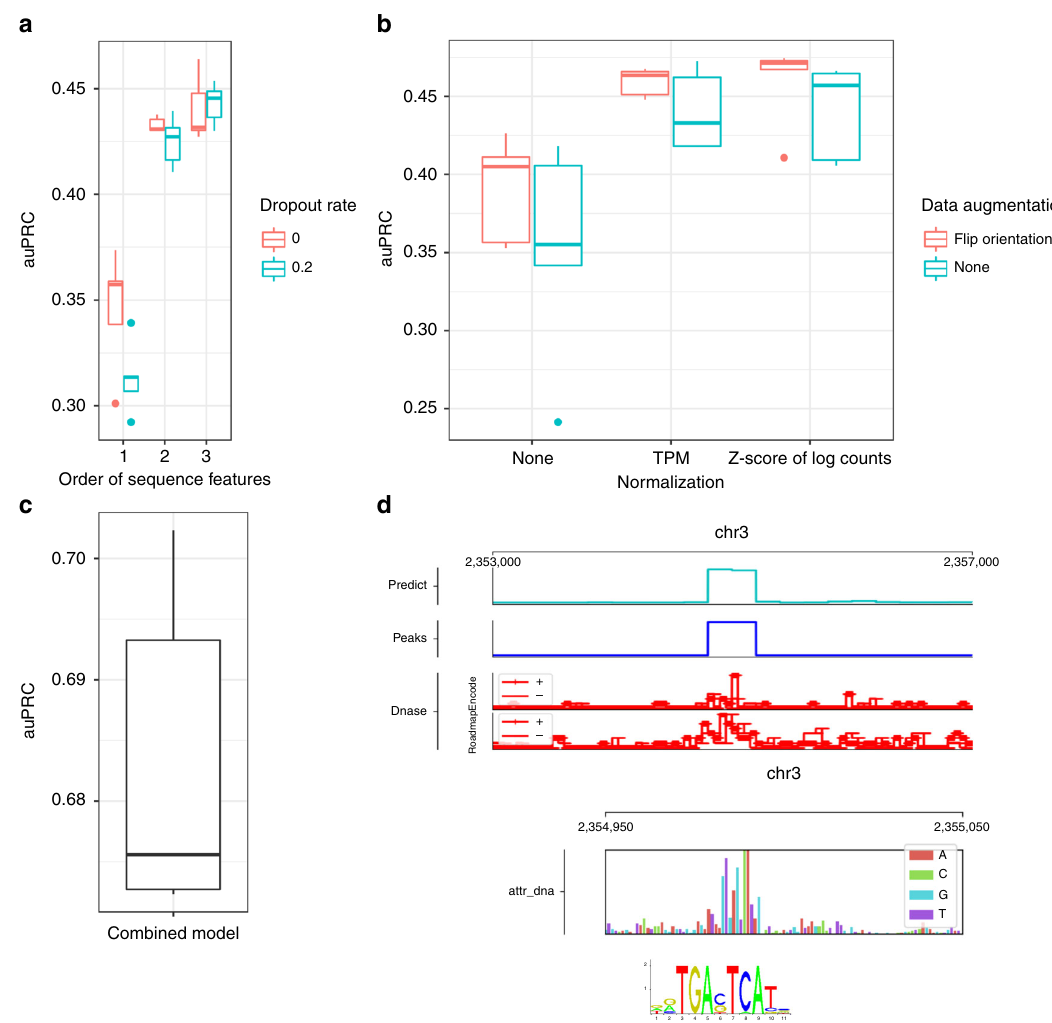
Fig. 2 Performance evaluation of JunD prediction. a Performance comparison of different one-hot encoding orders enabled by Janggu's Bioseq object. Order 1, 2, and 3 correspond to mono-, di- and tri-nucleotide based one-hot encoding, respectively. Each model was trained from scratch for fi ve times using random initial weights. Boxes represent quartiles Q1 (25% quantile), Q2 (median) and Q3 (75% quantile); whiskers comprise data points that are within 1.5 x IQR (inter-quartile region) of the boxes. b Performance comparison of different normalization and data augmentation strategies applied to the read counts from the BAM fi les. We compared (1) No normalization (None), (2) TPM normalization, and (3) Z score of log(count + 1) which are optionally available via the Cover object. Moreover, data augmentation consisted of (1) no augmentation (None) or (2) randomly fl ipping 5' to 3' orientations which was employed by Janggu ’ s dataset wrappers. Each model was trained from scratch for fi ve times using random initial weights. Boxplots are de fi ned as in ( a ). c Performance for JunD prediction for the combined model that takes DNA and DNase coverage into account. Each model was trained from scratch for fi ve times using random initial weights. Boxplots are de fi ned as in ( a ). d Example of a JunD binding site. The top-most panel shows predicted, true JunD binding site as well as the input DNase coverage around the peak. Underneath integrated gradients further highlights the importance of a site reminiscent of the known JunD motif (Jaspar motif: